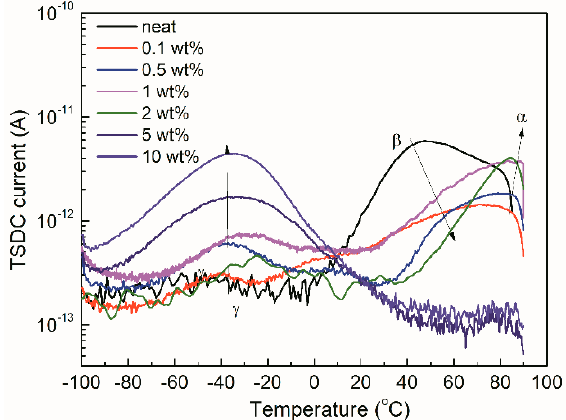
Figure 5. Thermally stimulated depolarization current (TSDC) results of neat LDPE and LDPE/TiO 2